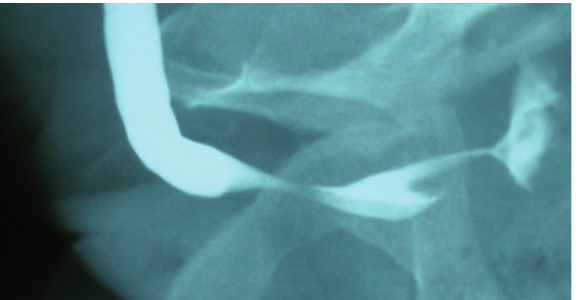
Figure 2 - Stricture as seen in Ascending urethrogram. Figure 4 - Diverticulum as seen in